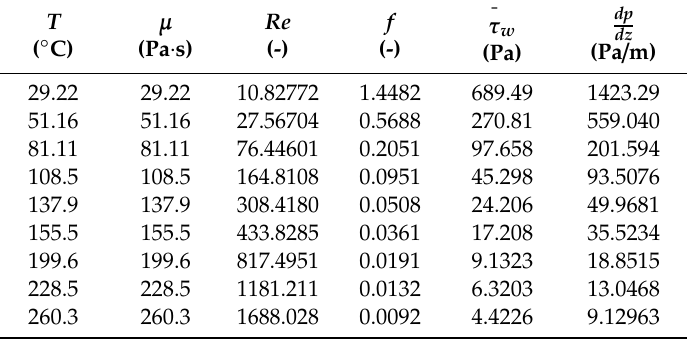
Table 6. Values of the fluid dynamic parameters obtained in the simulations with β = 0.02 and N = 16.